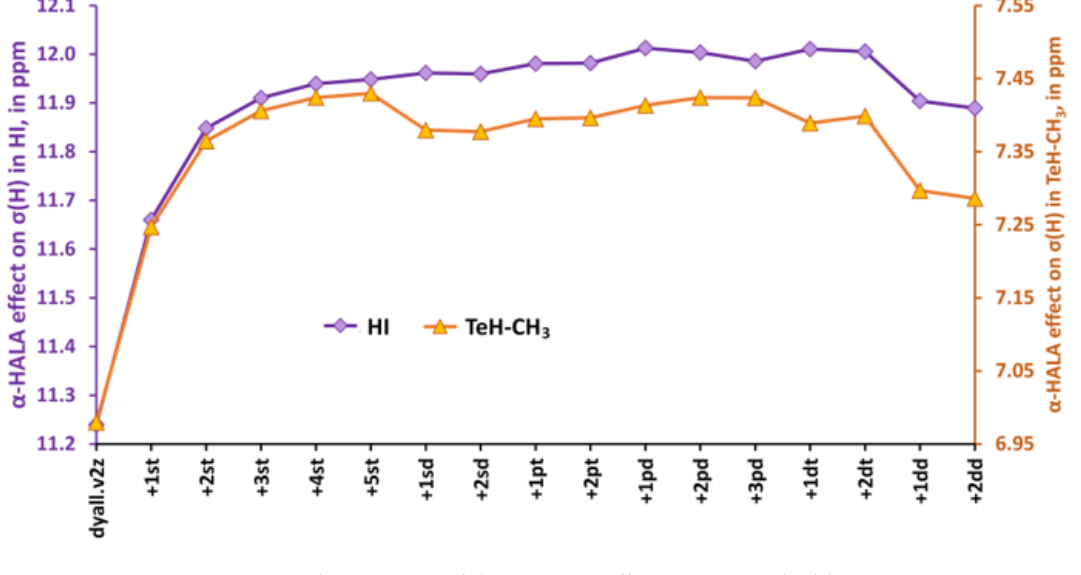
Figure 6. The variation of the α -HALA effect on proton shielding constant upon saturation of the dyall.v2z basis set on hydrogen atoms in molecules 1 and 6 .